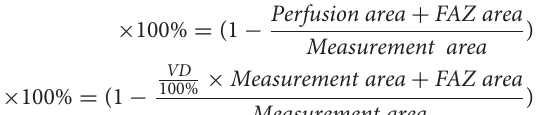
Perfusion area + FAZ area An example is shown in Figure 1 . The FAZ area measurement × 100% = (1 − ) Measurement area is located in the yellow area, VD measurement is located VD × Measurement area + FAZ area in the gray area, and macular ISI measurement is located 100% × 100% = (1 − ) in the blue area. The macular ISI mainly excludes the Measurement area × 100% influence of changes in the FAZ area and more intuitively represents the ischemic state in the macular region with Measurement area = 3 mm × 3 mm × π = 28.27 mm 2 a larger macular ISI indicating more severe ischemia and FAZ area VD − ) × 100% Macular ISI = (1 − 100% 28.27